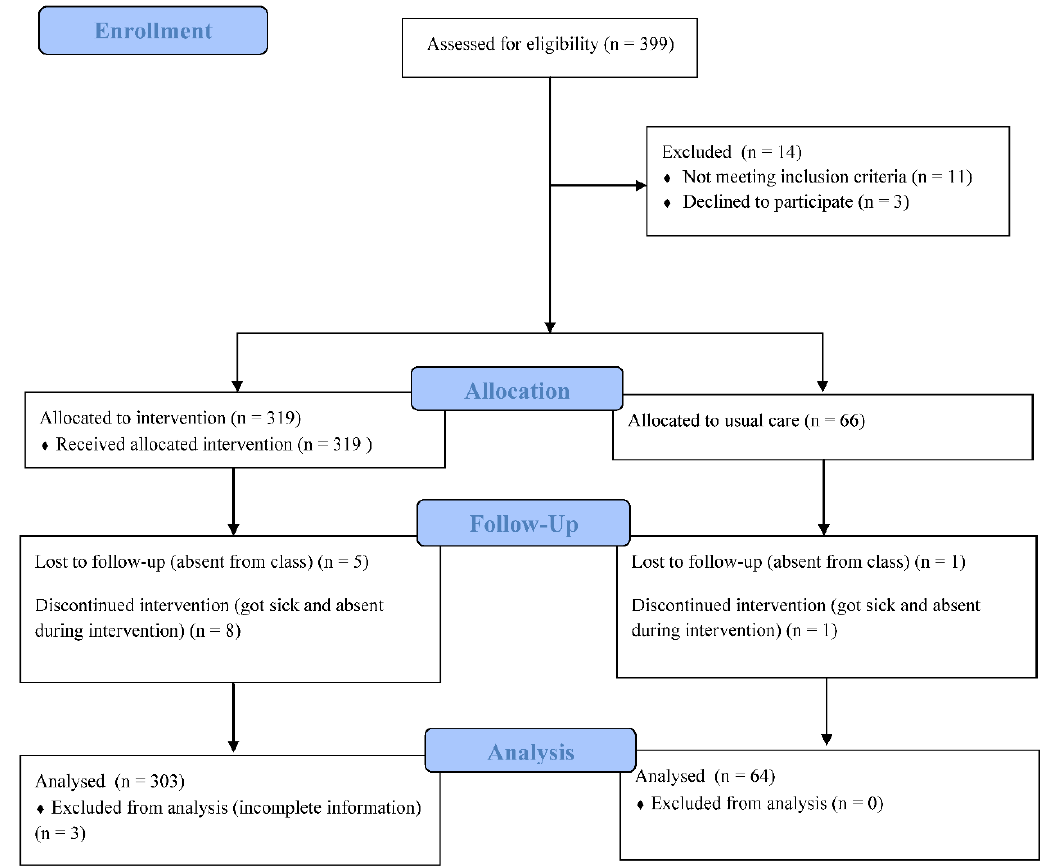
Figure 1. Flow Diagram of this study with Consolidated Standards of Reporting Trials (CONSORT).